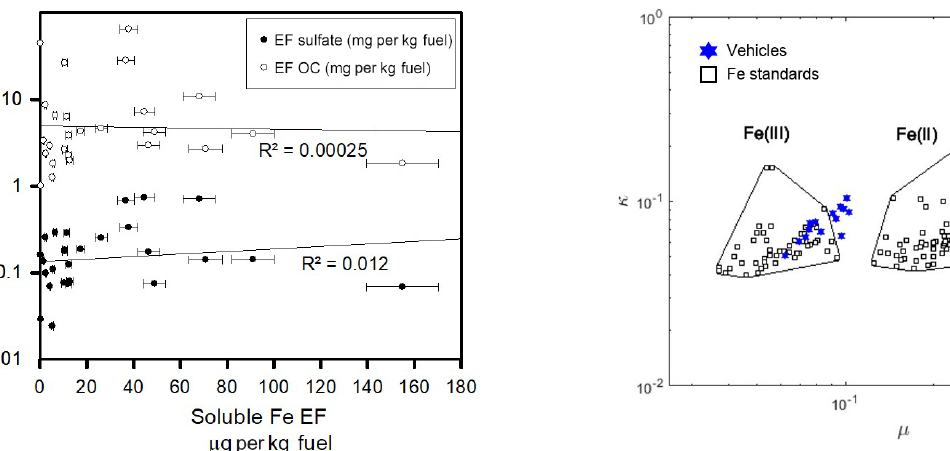
Figure 3. Linear correlation plots representing EF in milligrams per kilogram of fuel for sulfate and organic carbon (OC) in micrograms per kilogram of fuel for water-soluble iron. Correlation lines and R 2 values for all elements are shown.